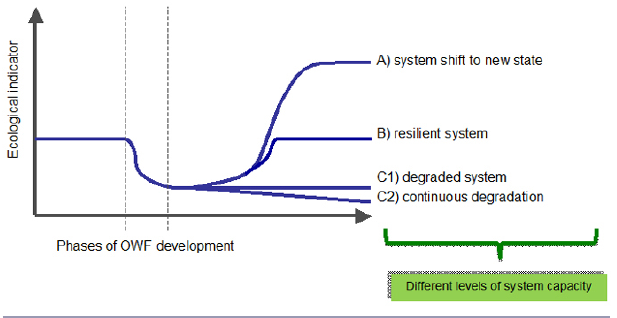
Fig. 2 . Possible ecosystem responses to offshore wind farm (OWF) construction phases (adapted from Burkhard et al. 2011 a ). See text for further